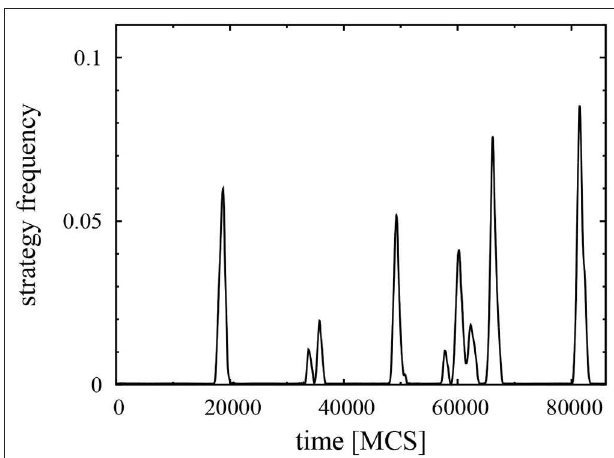
FIGURE 7 | The appearance, growth, and extinction of a burst is accompanied by a macroscopically detectable variation in the frequency of strategy 2. These MC data were obtained in a large system ( L same interaction parameters that were given in the caption of Figure 6